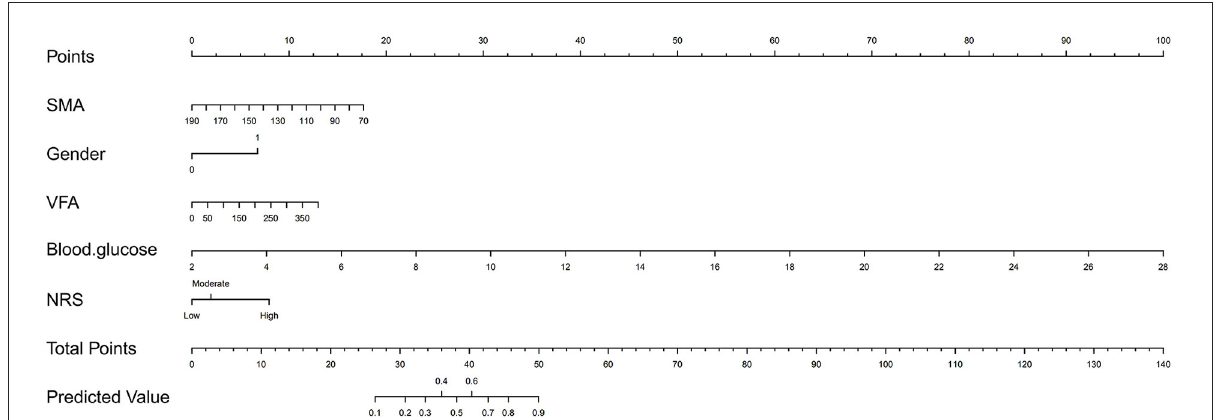
FIGURE2 Nomogram for predicting postoperative anastomotic leakage in patients with colorectal cancer.